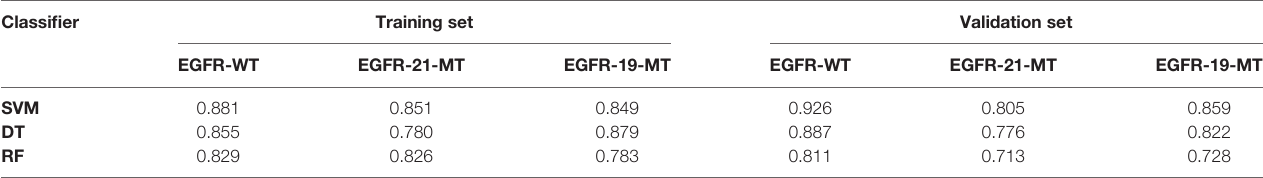
TABLE 2 | The predictive performance (area under the curve) of three classi fi ers in Training set and Validation set.